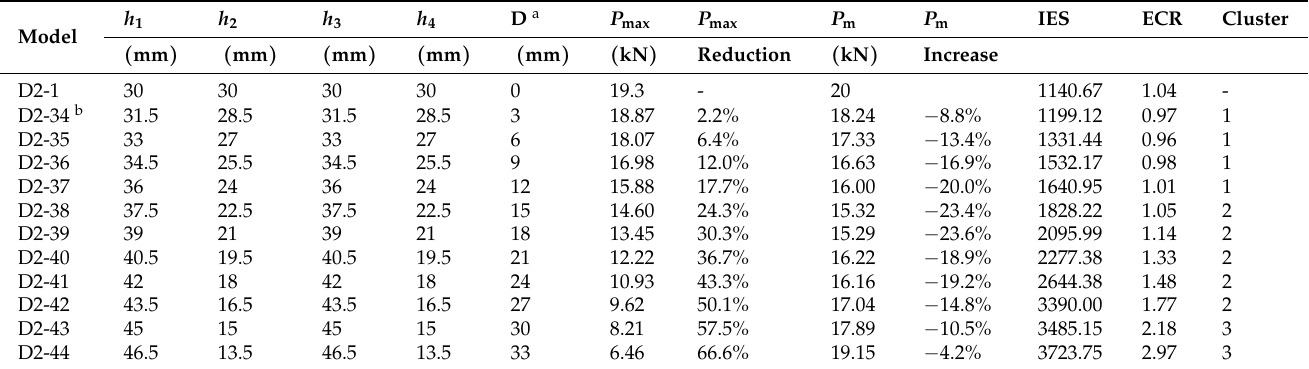
Table 3. The design parameters and simulation results of the secondary clustering model.